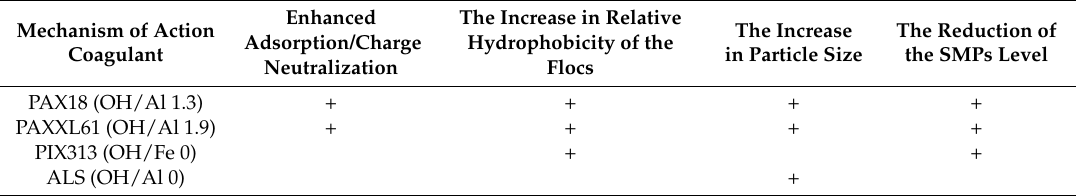
Table 3. Prevailing mechanisms of action for the tested